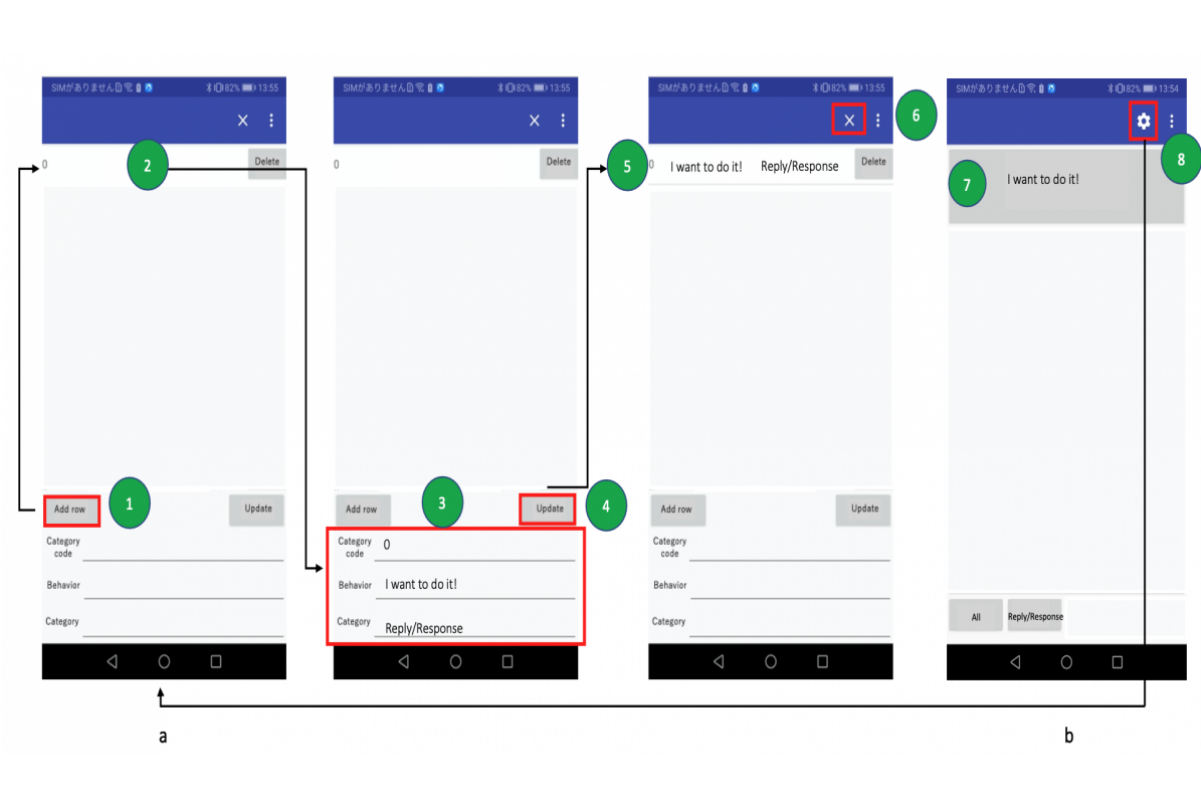
Figure 1. ChildSIDE user interface and guide. (a) Behavior settings, (b) behavior